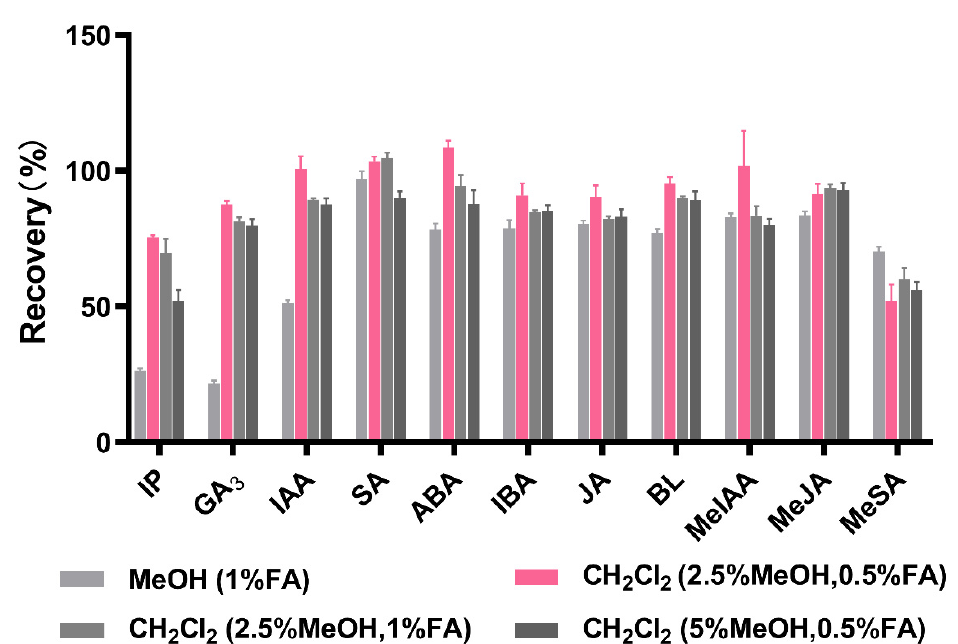
Figure 4. The effect of 4 different elution on recoveries of 11 phytohormones ( n = 3).